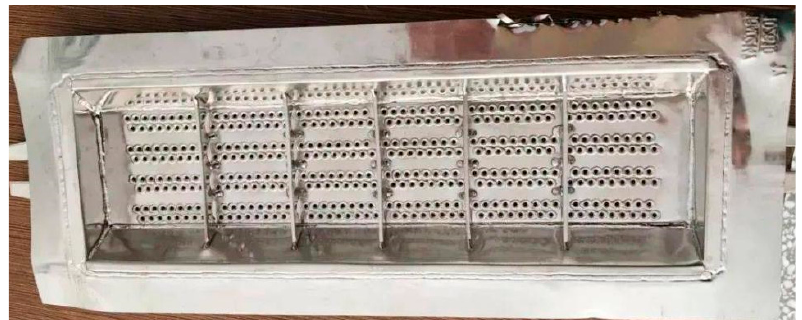
Figure 1. Pt–Rh bushing.